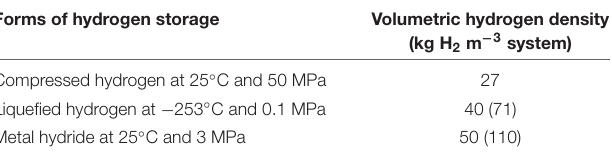
TABLE 1 | Hydrogen density comparison at system level and is the theoretical limit of the material in parenthesis (Züttel et al., 2010). Forms of hydrogen